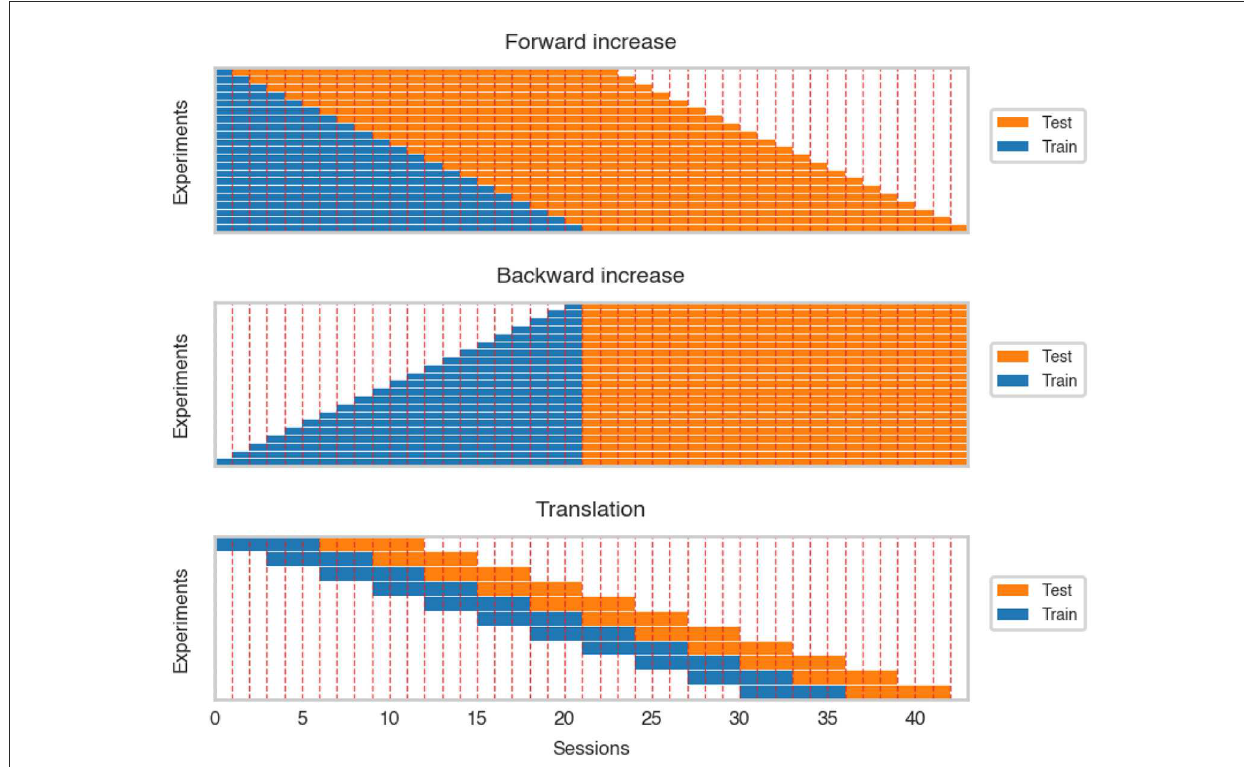
FIGURE3 Visualization of forward and backward increase and translation over the dataset. For clarity, we ignored differences in session